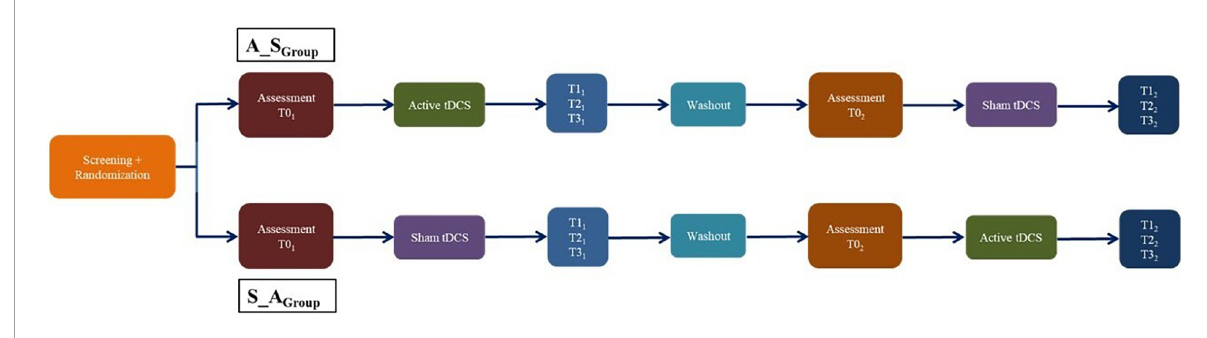
FIGURE2 The crossover